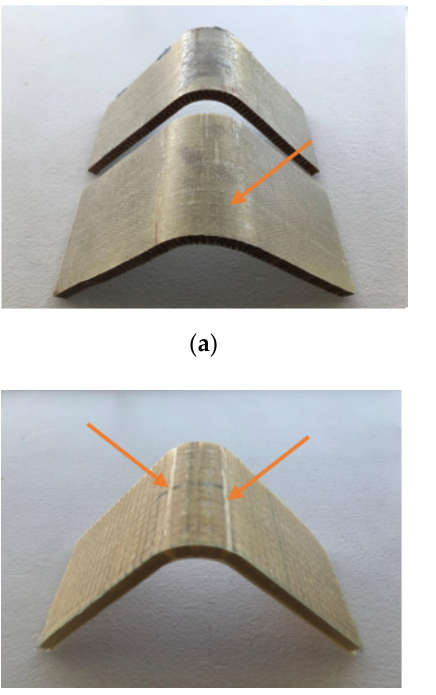
Figure 5. Picture corresponding to the gridding foam specimen placement in the V ‐ shaped mold before the preheated process.